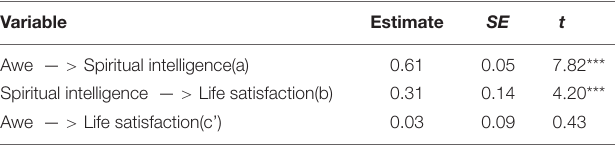
TABLE 3 | Path coefficient results for awe, spiritual intelligence, and life satisfaction. Variable Estimate SE t